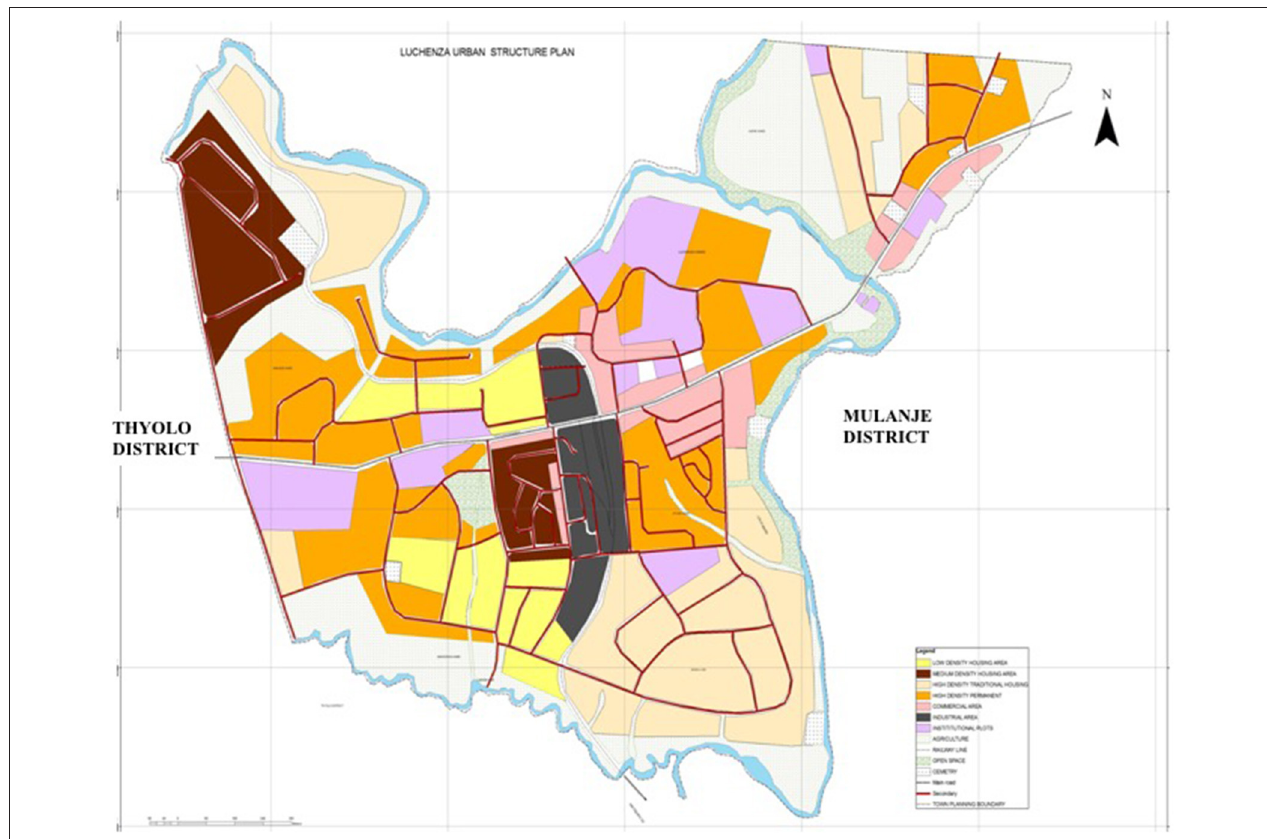
FIGURE 2 | Map of